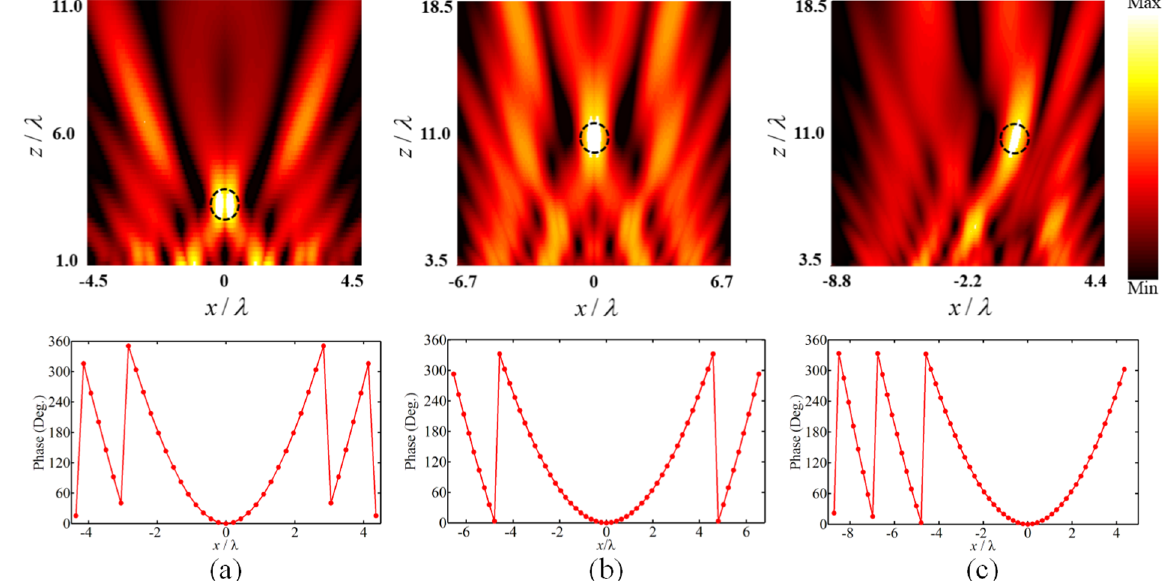
Figure 4. Simulation results of electric field distribution and phase distribution of metasurface for single-focus metamirrors. The incidence wave is converged to three specific points located at ( a ) x = 0, z = 3.5 λ , ( b ) x = 0, z = 11 λ , and ( c ) x = 1 λ , z = 11 λ